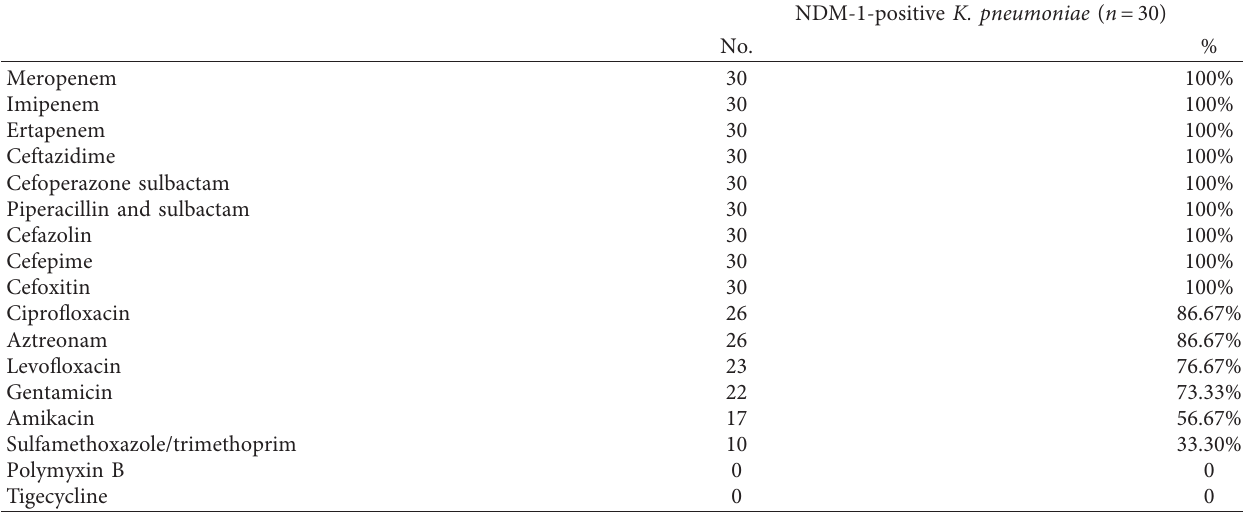
Table 2: The antimicrobial resistance profiling of NDM-1-positive K.